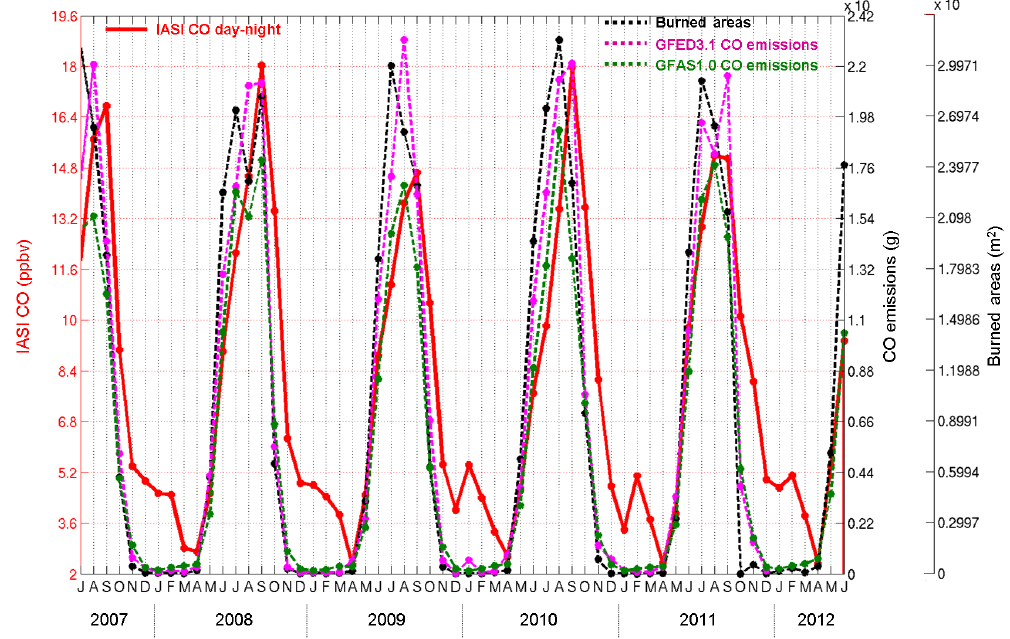
Figure 4. Evolution of the day–night difference of the integrated content of CO from IASI on land, and of fires, between July 2007 and June 2012 in southern Africa. Red: day–night CO. Black dashed: MODIS burned areas. Purple dashed: CO emissions from GFED3.1. Green dashed: CO emissions from